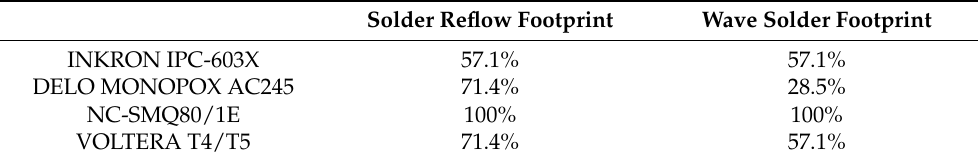
Table 6. Percentage of correct package soldered with stencil printing